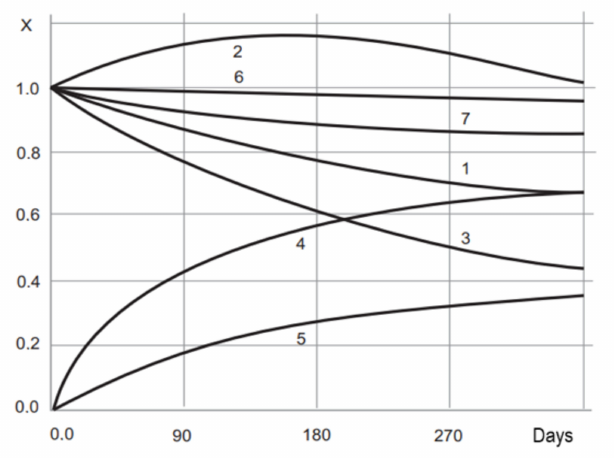
Figure 5. Change ( x ); strength ( 1 ); tensile modulus ( 2 ); elongation ( 3 ); mass ( 4 ); structure damage ( 5 ) of epoxy composition (composition 6 of Table 1); adhesion strength ( 6 ); thermal conductivity ( 7 ); during climatic